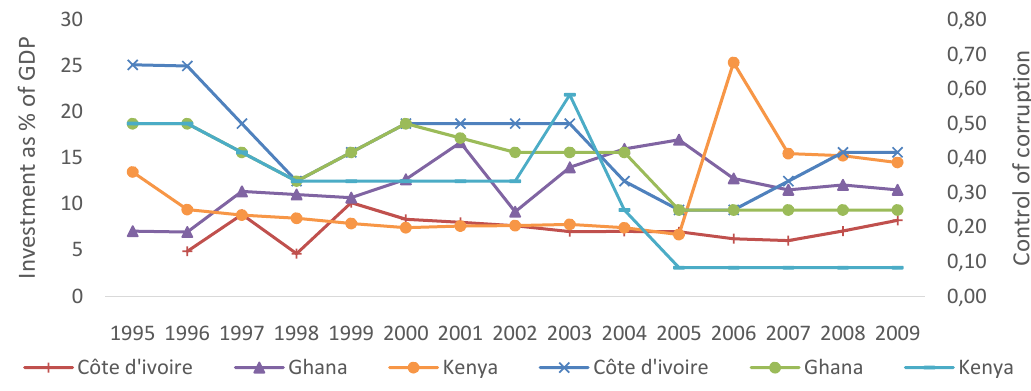
Fig. 4. Control of corruption and investment (gross fixed capital formation-private) Source: authors’ computation.